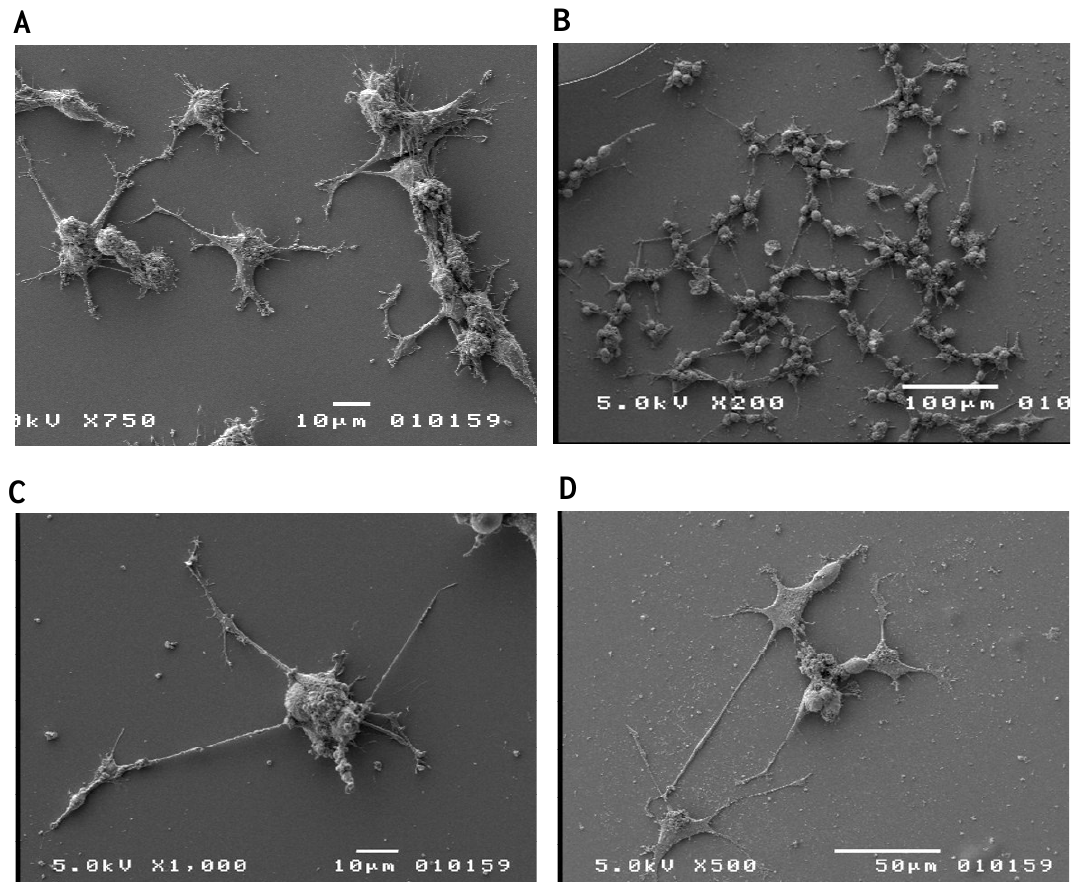
Figure 5. PC12 cells were induced to differentiate after NGF treatment A: 1 day; B: 2days; C: 3 days; D: 4 Days.